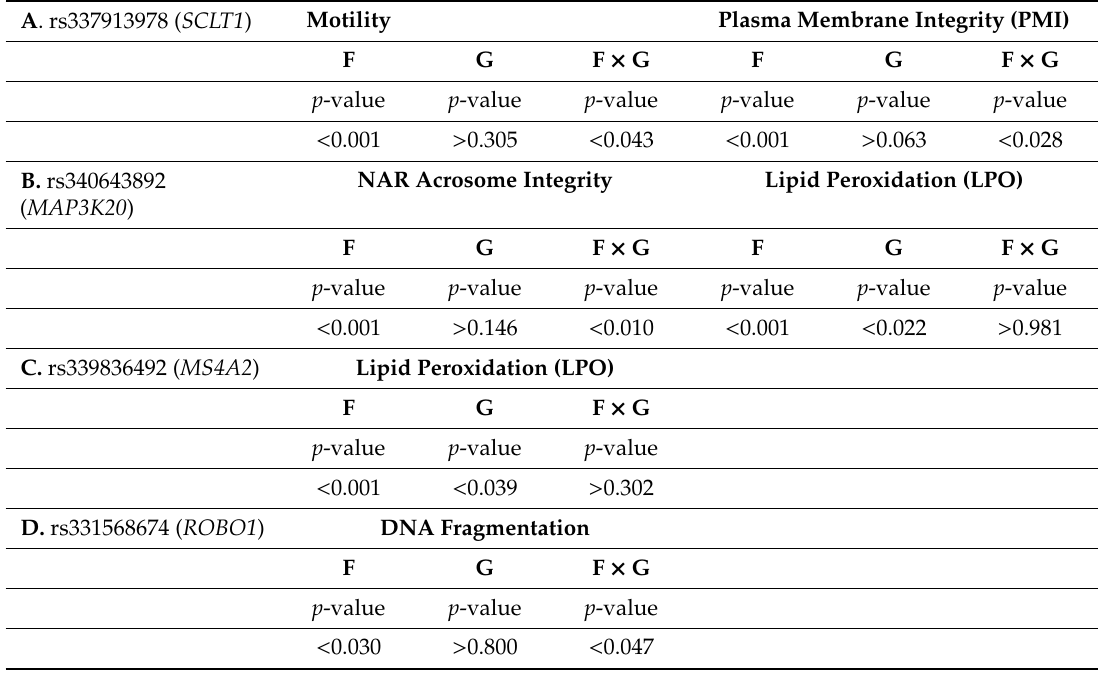
Table 5. ANOVA analysis showing the e ff ects of freezability (F) and gene polymorphism (G) on post-thaw semen